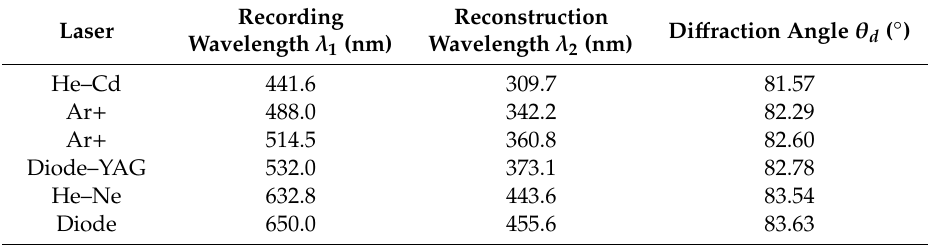
Figure 8. Relationships of ( a ) reconstruction wavelength λ 2 versus recording wavelength λ 1 and di ff raction angle θ d versus recording wavelength λ 1 ; ( b ) reconstruction wavelength λ 2 versus base angle θ p 1 of right-angle prism. Table 1. Corresponding reconstruction wavelengths and di ff raction angles for commercial